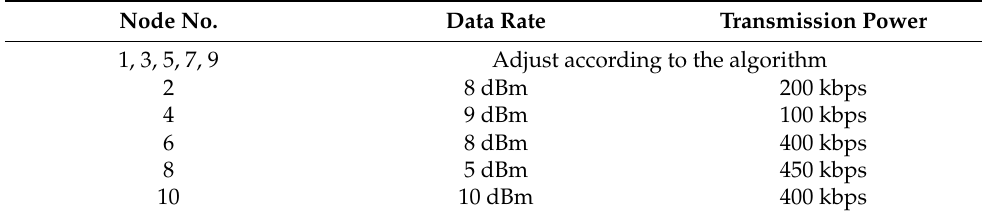
Table 7. Data rate and transmission power of sensor nodes.